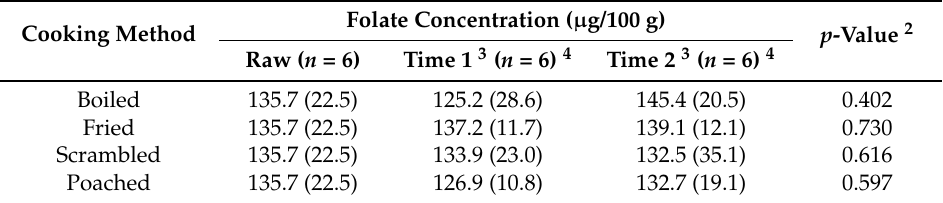
Table 2. Total folate content ( µ g/100 g) of folate-enriched eggs following four typical cooking treatments 1